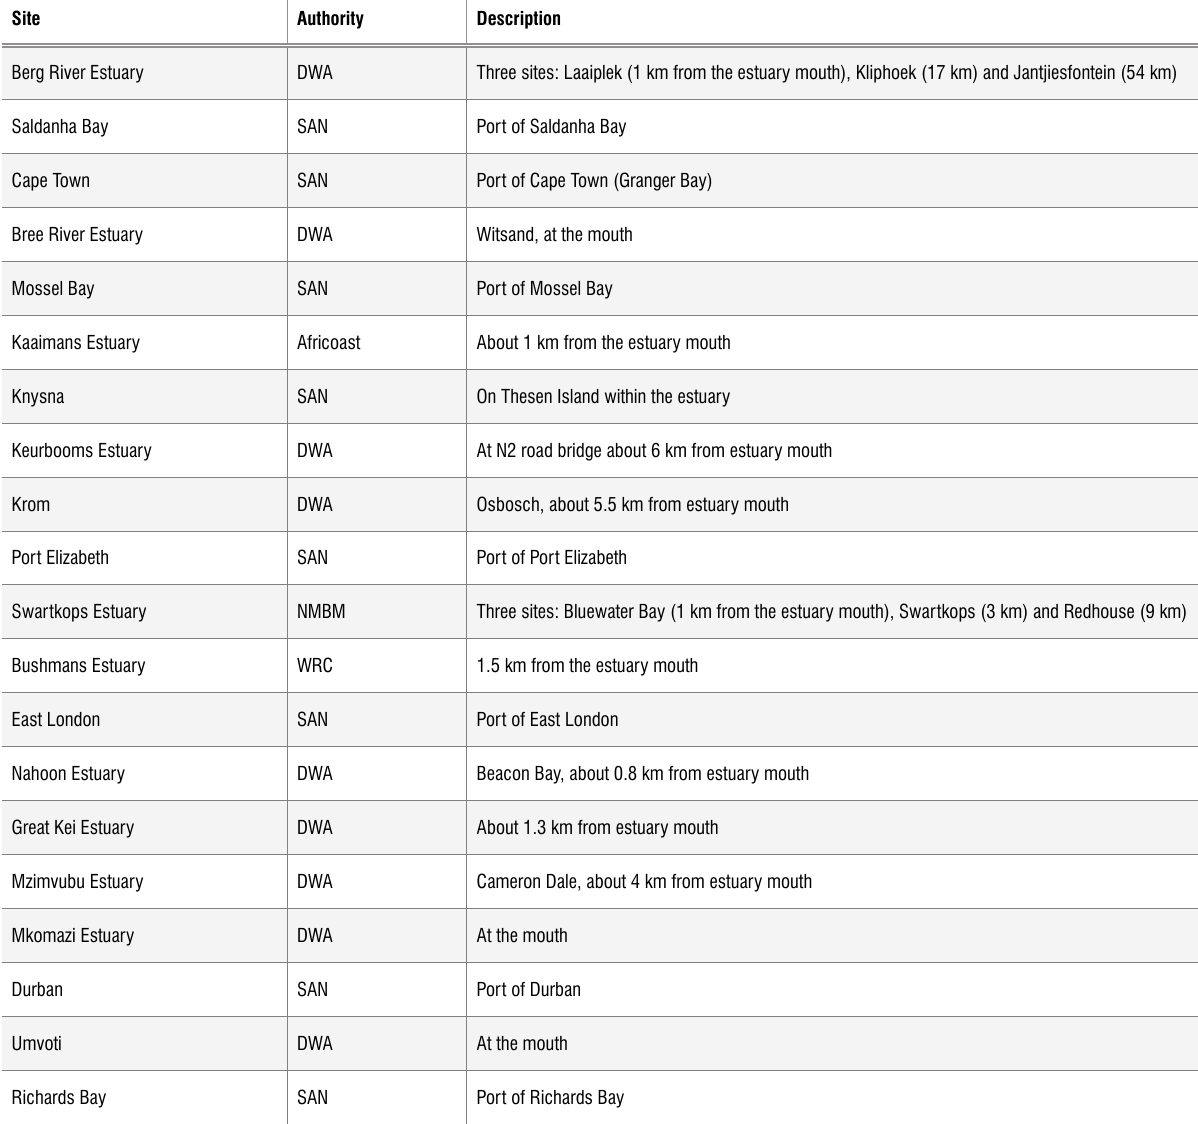
Table 1: Details of water level measurements made at various ports and estuaries in South Africa (locations are shown in Figure 1)